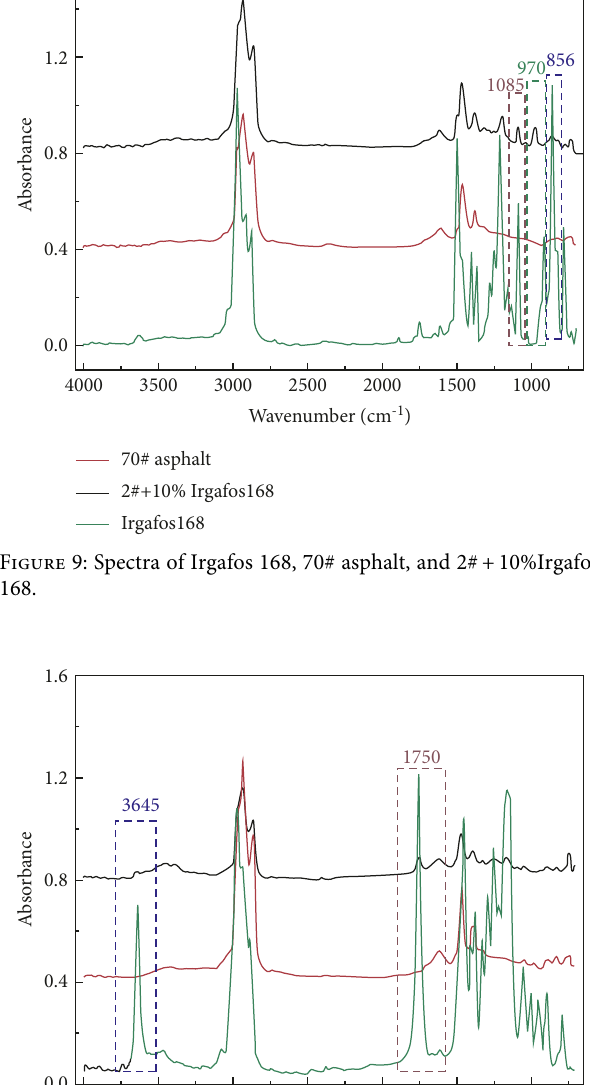
Table 5: Spectral analysis of main absorption peaks in modified asphalt.